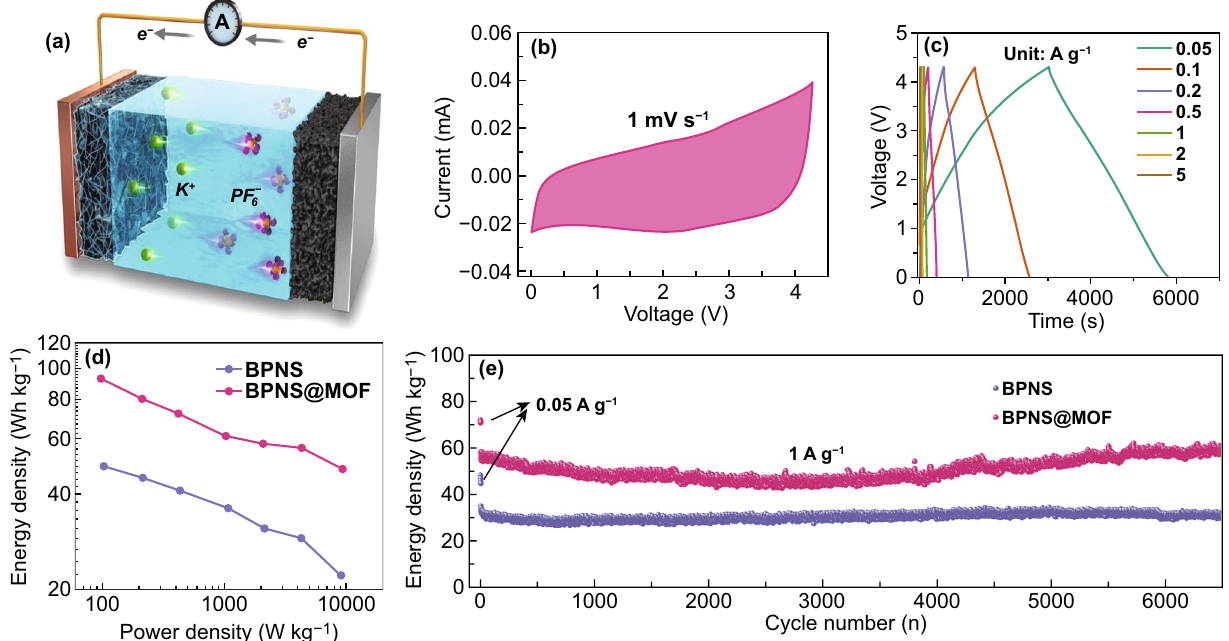
Fig. 5 a Schematic configuration of a KIC device. b CV curve of the BPNS@MOF electrode at scan rate of 1 mV s −1 . c Galvanostatic charge/ discharge curves of the BPNS@MOF//AC full cells at different current densities. d Ragone plots of the BPNS//AC and BPNS@MOF//AC elec- trodes for KIC. e Cyclic performance of the BPNS//AC and BPNS@MOF//AC electrodes for